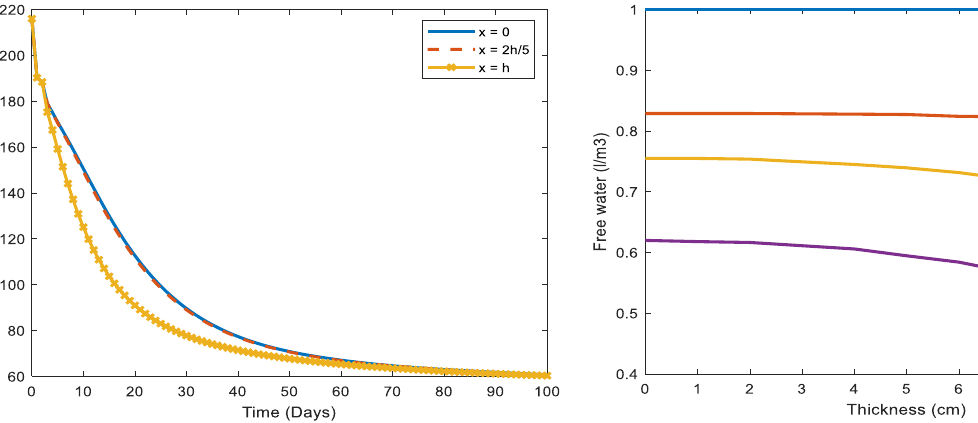
Figure 10: Water variation in the cross